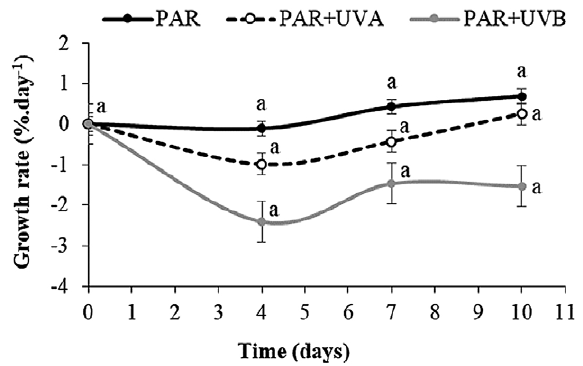
Fig. 2. – Growth rate of Sargassum filipendula over 10 days of ex- posure to PAR, PAR+UVA, and PAR+UVB radiation treatments (n=5; mean±SD). Letters indicate differences according to repeated measures